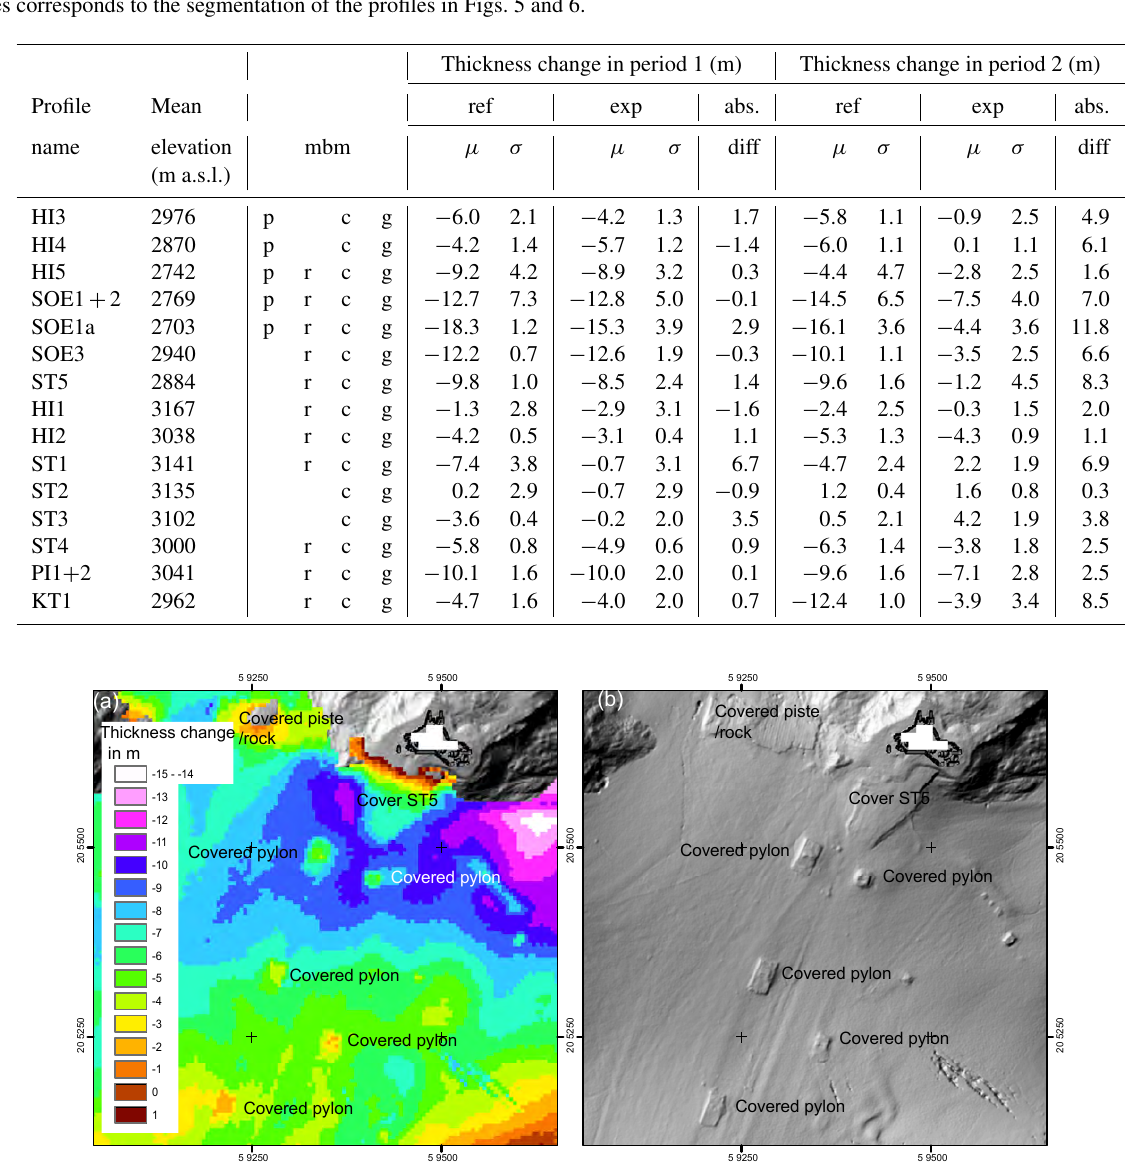
Table 3. Mean elevation of the profiles and the applied mass balance management measures (mbm) snow production (p), snow relocation (r), snow covering (c), and piste grooming (g). The mean ( µ ) and the standard deviation ( σ ) of surface elevation changes in metres for experimental areas (exp) and reference areas (ref) at the profiles in the periods without (p1) and with (p2) mass balance management are shown. Absolute differences (abs. diff, in metres) of the exp mean values to the ref mean values are given. Note that the arrangement of the profiles corresponds to the segmentation of the profiles in Figs. 5 and 6.